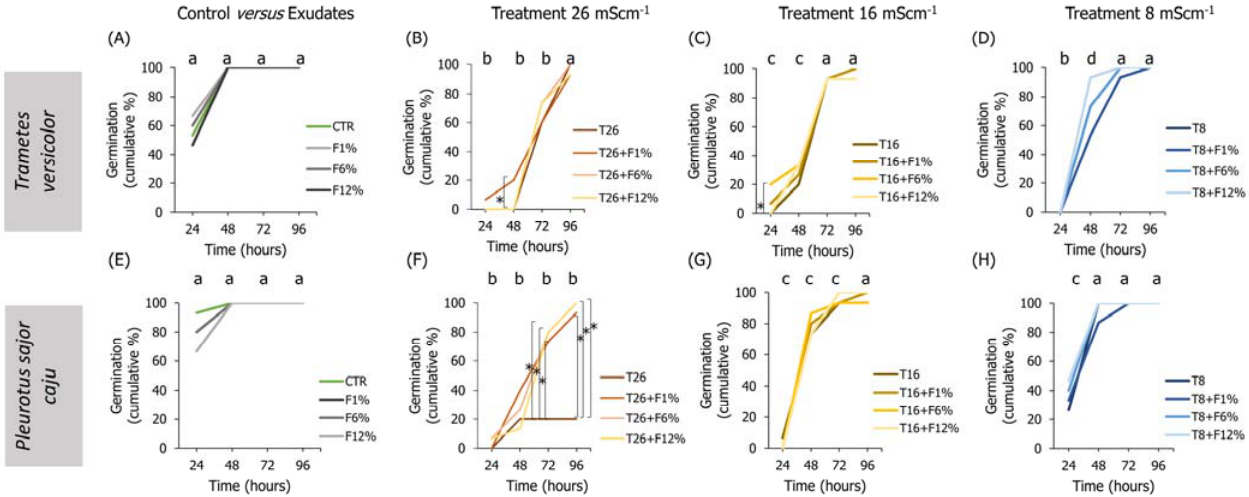
Figure 4. Lens culinaris germination rates, at 96 h, in LUFA 2.2 soil salinized at three different levels (8, 16, and 26 mS · cm − 1 , designated as T8, T16, and T26, respectively) and supplemented with fungi exudates at three levels (1%, 6, and 12%, designated as F1%, F6%, and F12%, respectively). Graphics